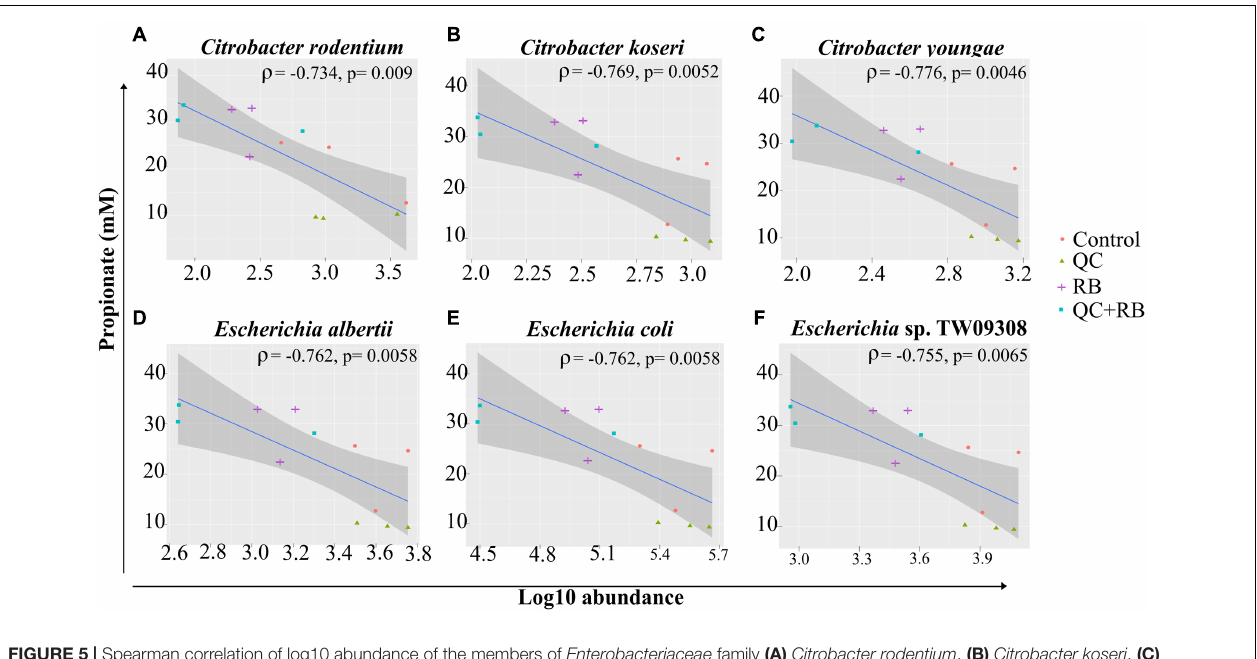
FIGURE 5 | Spearman correlation of log10 abundance of the members of Enterobacteriaceae family (A) Citrobacter rodentium , (B) Citrobacter koseri , (C) Citrobacter youngae , (D) Escherichia albertii , (E) Escherichia coli , and (F) Escherichia sp. TW09308 at day 21 determined by shotgun metagenomics sequence analysis to levels of propionate in the medium. A negative correlation is expressed by negative values of correlation coefficient “rho” ( ρ ) with corresponding p